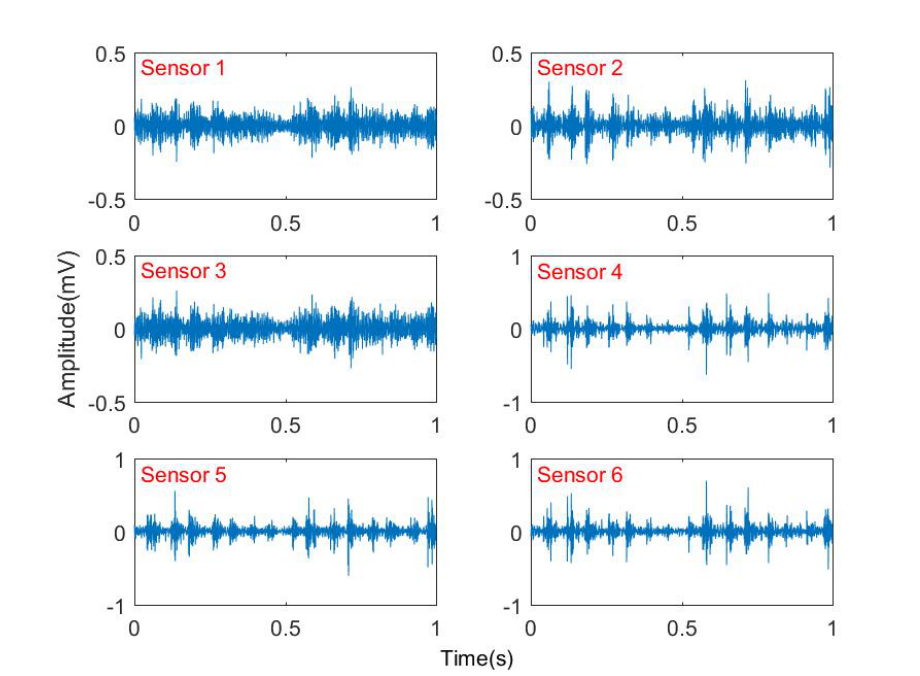
Figure 7. Waves of vibration signals under ball fault.